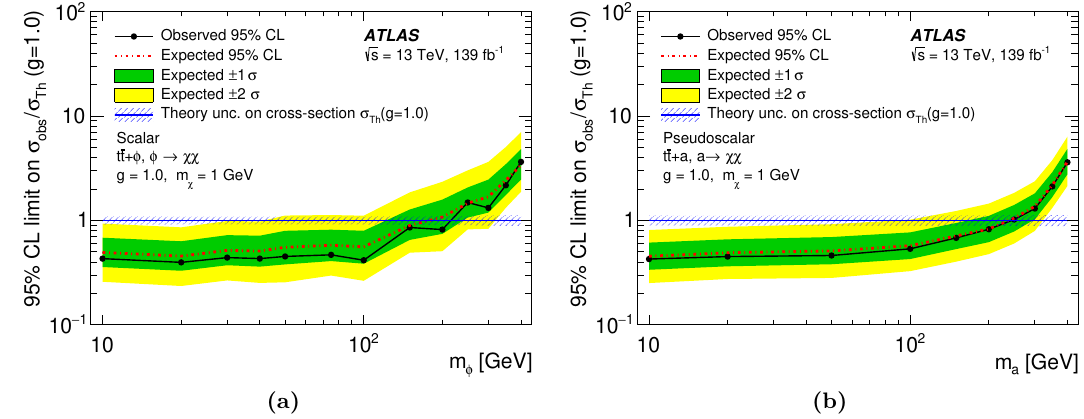
Figure 15. Upper limit on the ratio of the production cross-section for the spin-0 mediator model to the theoretical cross-section under the hypothesis of (a) a scalar or (b) a pseudoscalar mediator. The limit is shown as a function of the mediator mass for a fixed mass of the DM candidate of 1 GeV. The coupling of the mediator to SM and DM particles is assumed to be g = 1